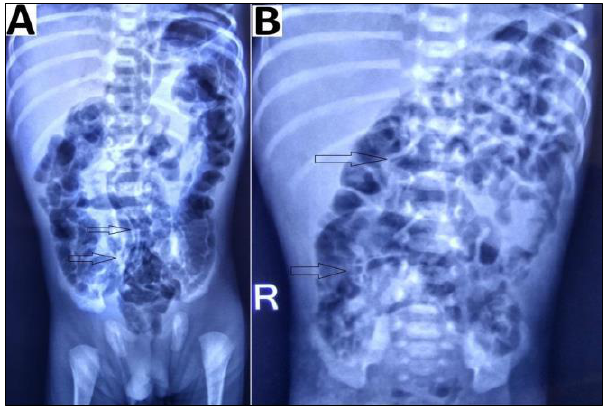
Figure 5: Radiographs showing (A) pneumatosis intestinalis with linear gas pattern (black arrow) and (B) bubbly gas pattern (black arrow). Portal venous gas secondary to resorption of air bubbles from the intestine into the portal venous system is less common than intestinal